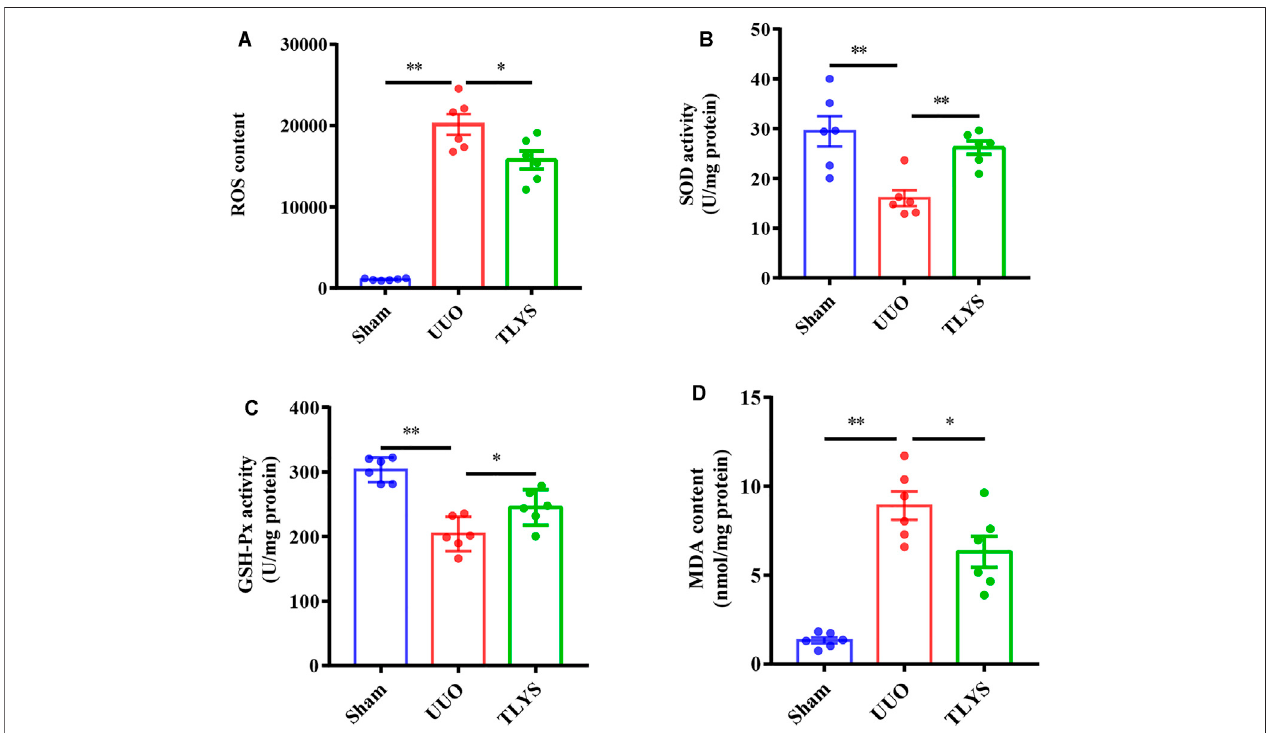
FIGURE 7 | TLYS decoction ameliorated oxidative stress in UUO rats. The renal tissues were taken to evaluate the contents of ROS (A) , superoxide dismutase (SOD) (B) , glutathione peroxidase (GSH-Px) (C) , and malondialdehyde (MDA) ( n (cid:2) 6). Data were presented as means ± SEM. * p < 0.05, ** p < 0.01.